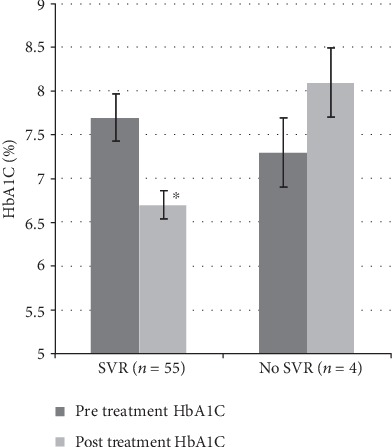
Mean ± SEM initial and final hemoglobin A1C levels (%) in the 59 treated patients shown in Figure 1, subgrouped as to whether patients had achieved a SVR (n = 55) or no SVR (n = 4). The difference between the SVR and no SVR patients was significant, as was the difference between pretreatment and posttreatment HbA1C levels in SVR patients (∗P < 0.0001). SVR: sustained virologic response.